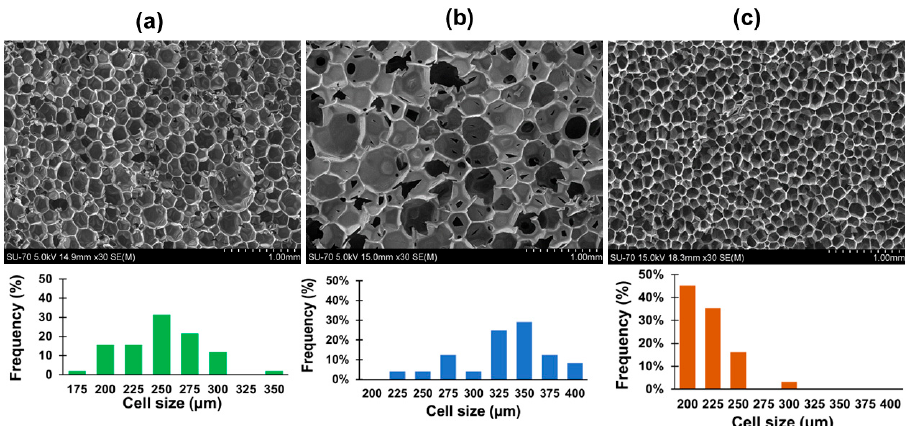
Figure 4. SEM micrographs and cell size distribution of bio-based RPUF ( a ), RPUF-conv ( b ) and RPUF-commercial ( c ). Free ascent direction and a 30 × magnification were used.